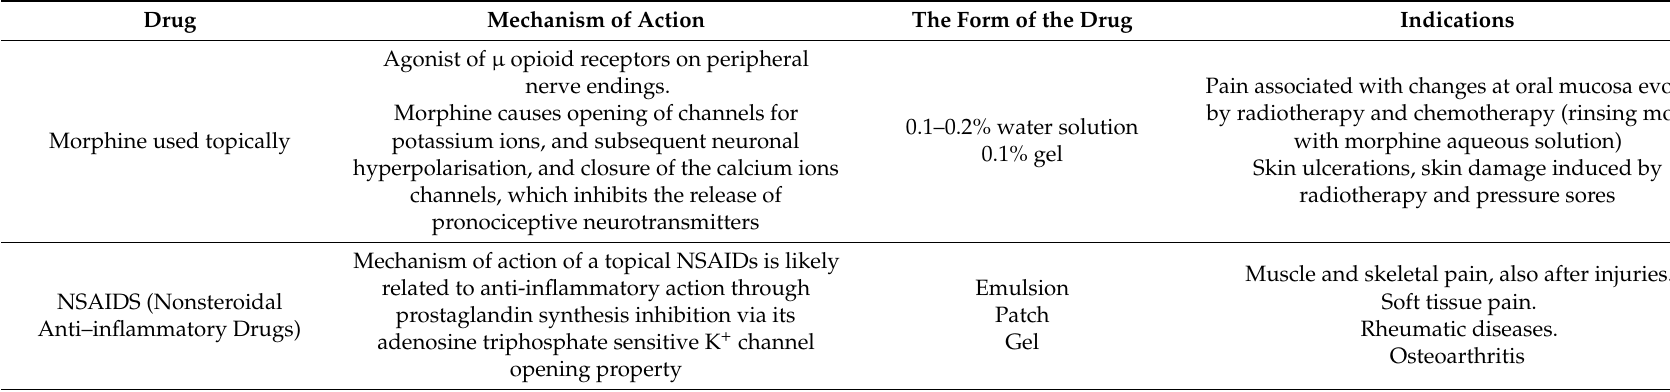
Table 5. Topical application for locally acting